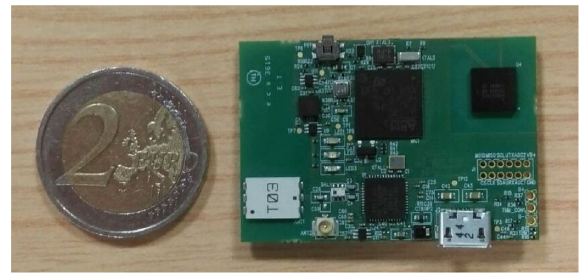
Figure 2. Hardware platform used for data collection.